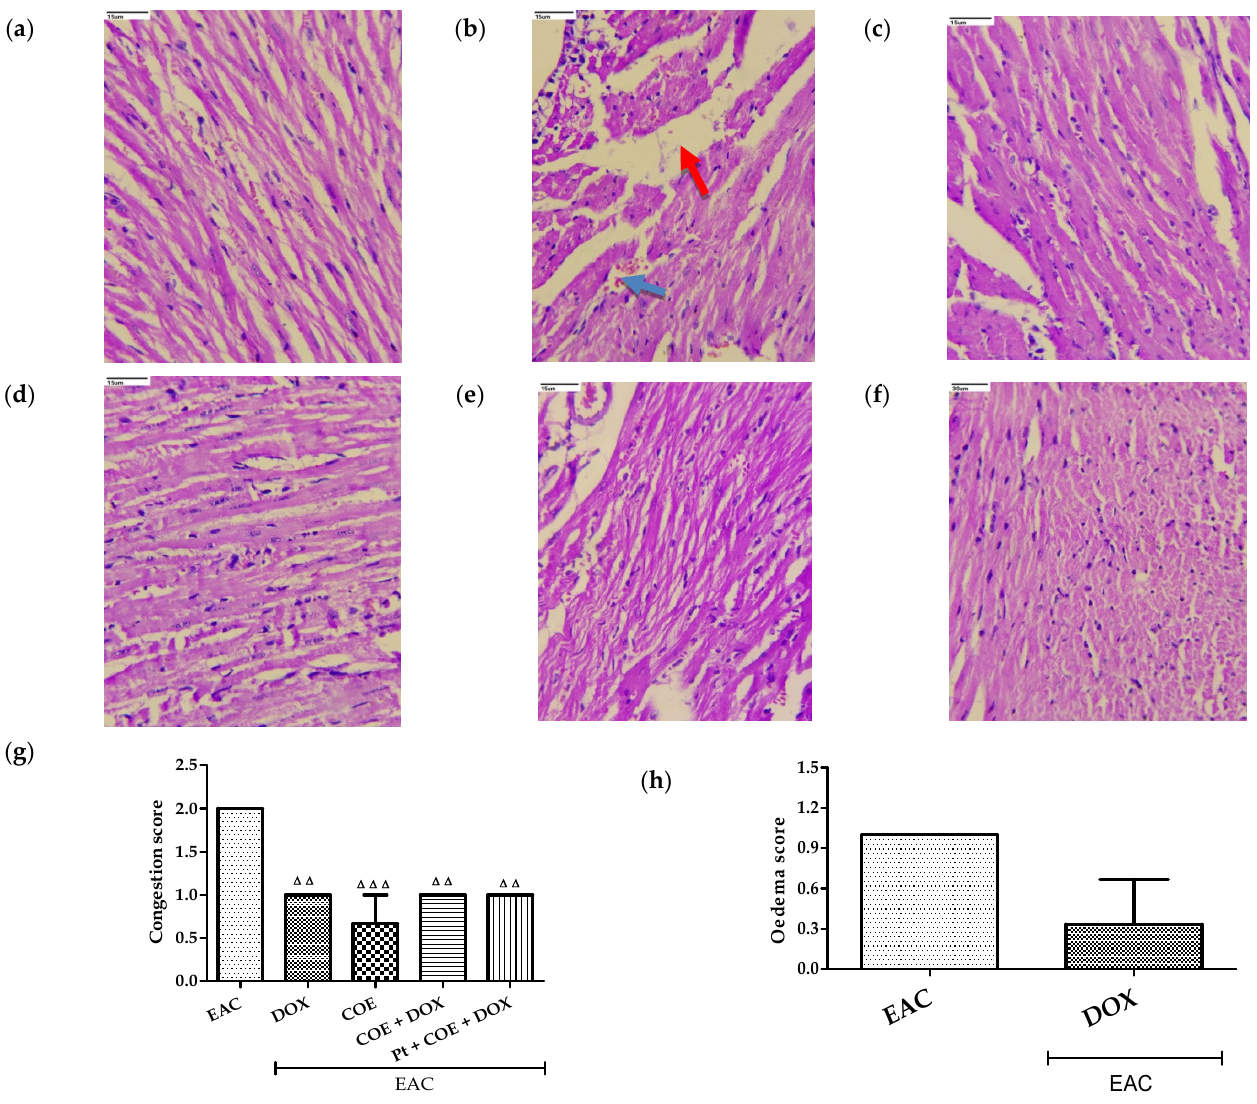
Figure 4. Effect of COE on cardiac histology. Photograph of heart sections of different treatment groups stained with haematoxylin and eosin. Plates at 40 × magnification. ( a ) Normal, ( b ) EAC, ( c ) DOX, ( d ) COE, ( e ) COE + DOX, ( f ) Pt + COE + DOX, ( g ) Congestion score, and ( h ) Oedema score. EAC group ( b ) showing oedema (red arrow) and congestion (blue arrow). All values are expressed as the mean ± SEM (n = 3). Data were analysed using one-way analysis of variance (ANOVA) followed by Tukey’s test ∆∆ p < 0.01, ∆∆∆ p < 0.001 compared with EAC.